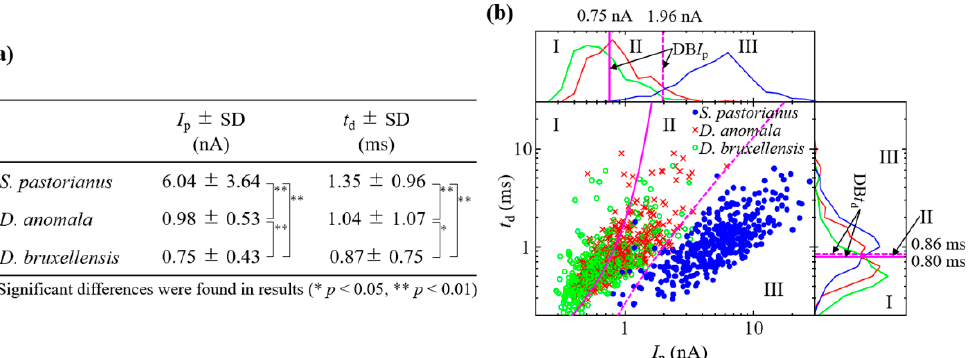
Figure 2. Reproducibility of I p and t d measurement by RPM for ( a ) S. pastorianus , D. anomala , and bruxellensis . ( b ) Histogram of I p on log, t d on log, I p - t d on log-log, and DBs for S. pastorianus , D. anomala , and D. bruxellensis .